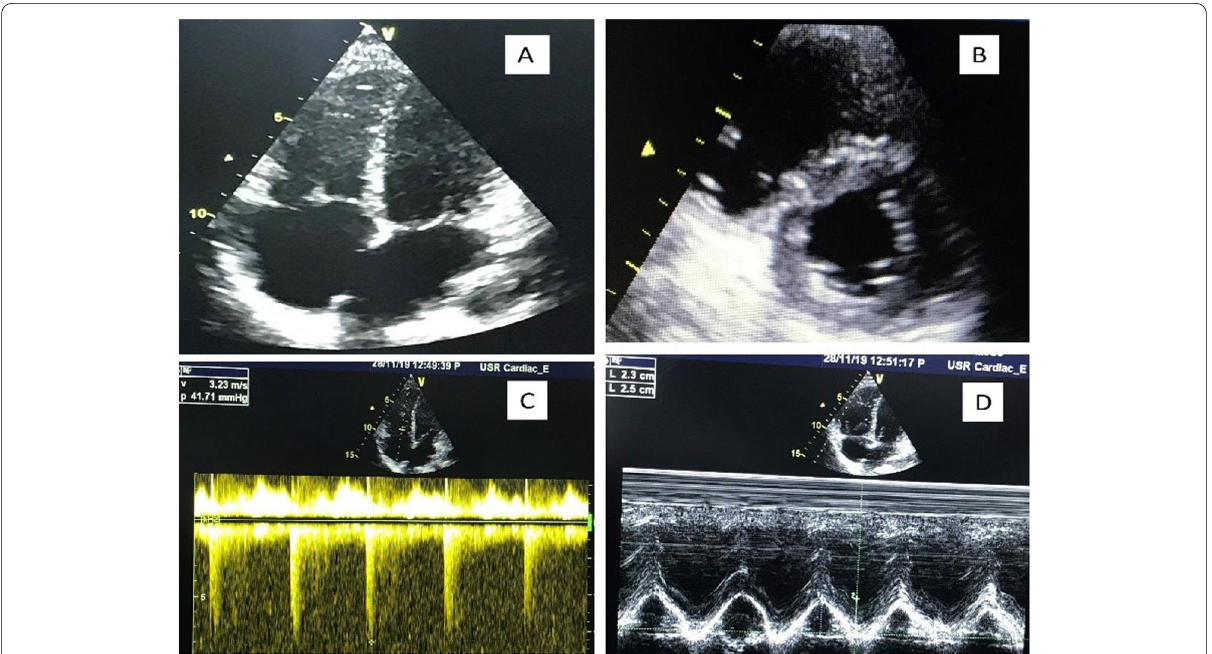
Fig. 1 A Apical four chamber view showing large ostium secundum ASD. B Parasternal short axis view showing severely dilated right ventricle. C PW Doppler at tricuspid valve showing pressure gradient between RA and RV. D M mode at lateral tricuspid annulus to measure